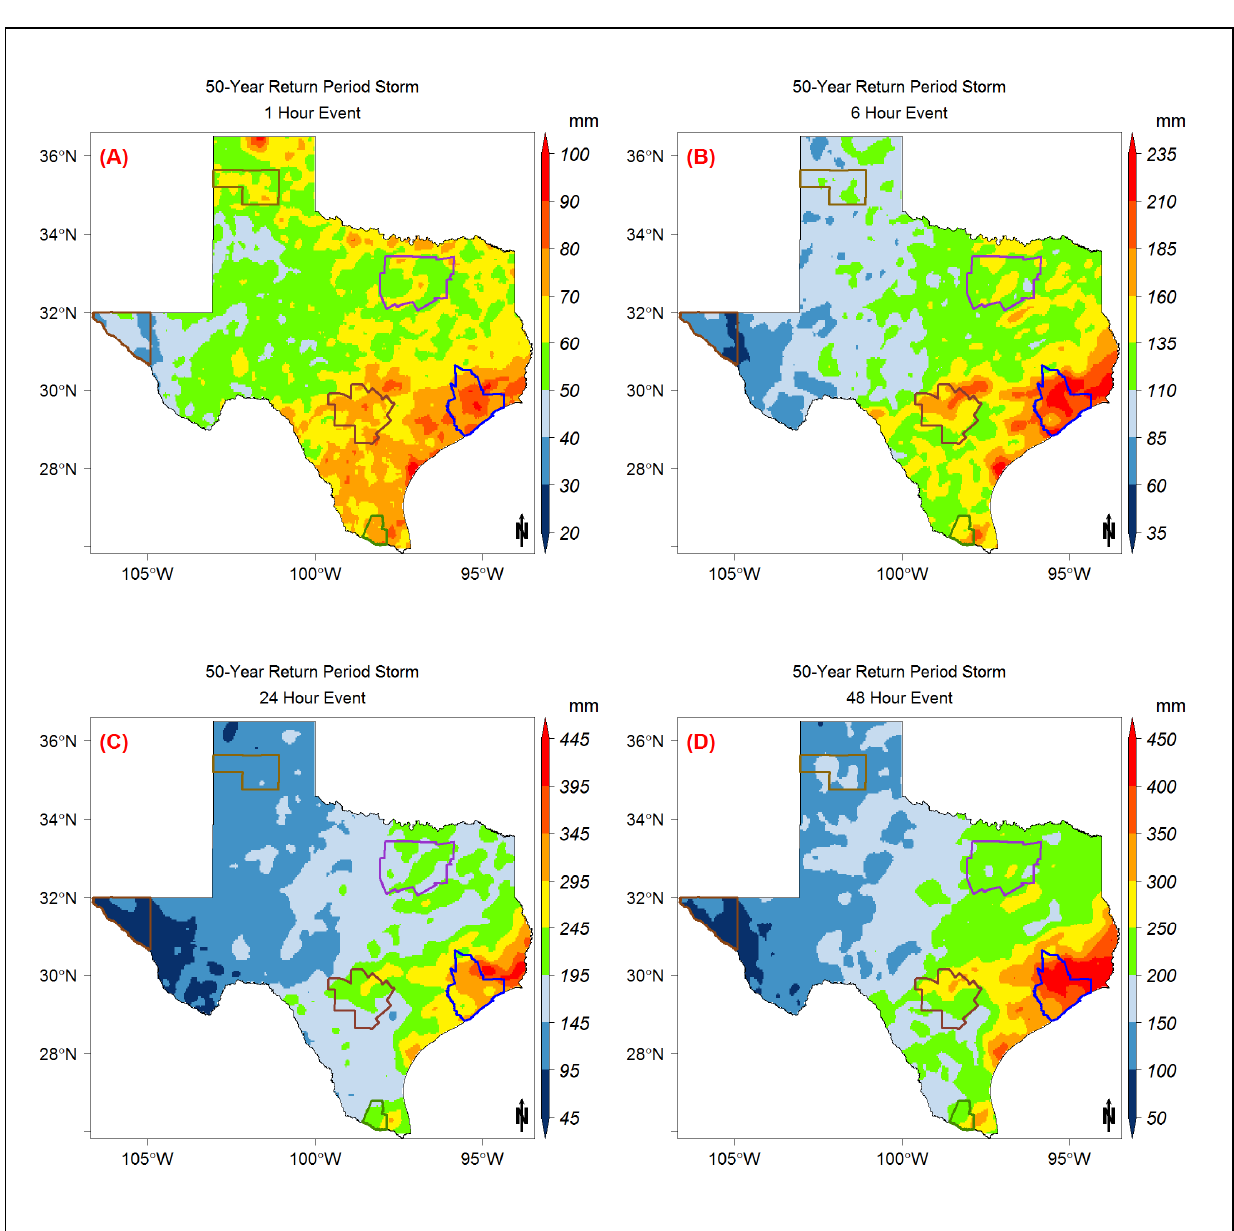
Figure A8. The 50-year return period storm event map modeled using the Gumbel model distribution for the ( A ) 1-h, ( B ) 6-h, ( C ) 24-h, and ( D ) 48-h storm durations.